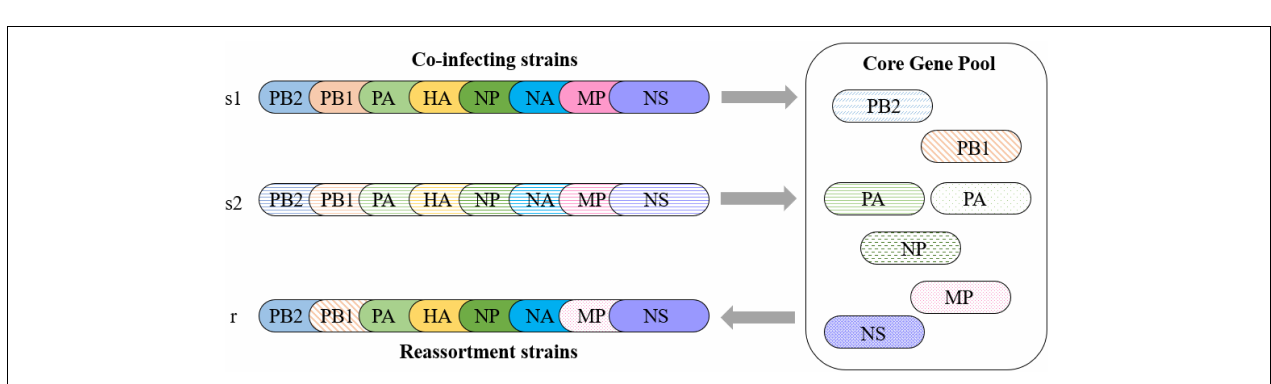
FIGURE 5 | Dimensionality reduction scatter plots of H7N9 and H9N2. The horizontal and vertical coordinates are the values of the horizontal and vertical coordinates corresponding to the downscaling of the sequence feature vector to a two-dimensional space, which has no practical significance. A green dot represents a H9N2 virus, while a yellow dot represents a H7N9 virus. The closer the two virus sequence feature vectors are, the more concentrated the two dots are. We only studied the relationship between H9N2 and H7N9, so other AIV subtypes are represented by dark purple dots.